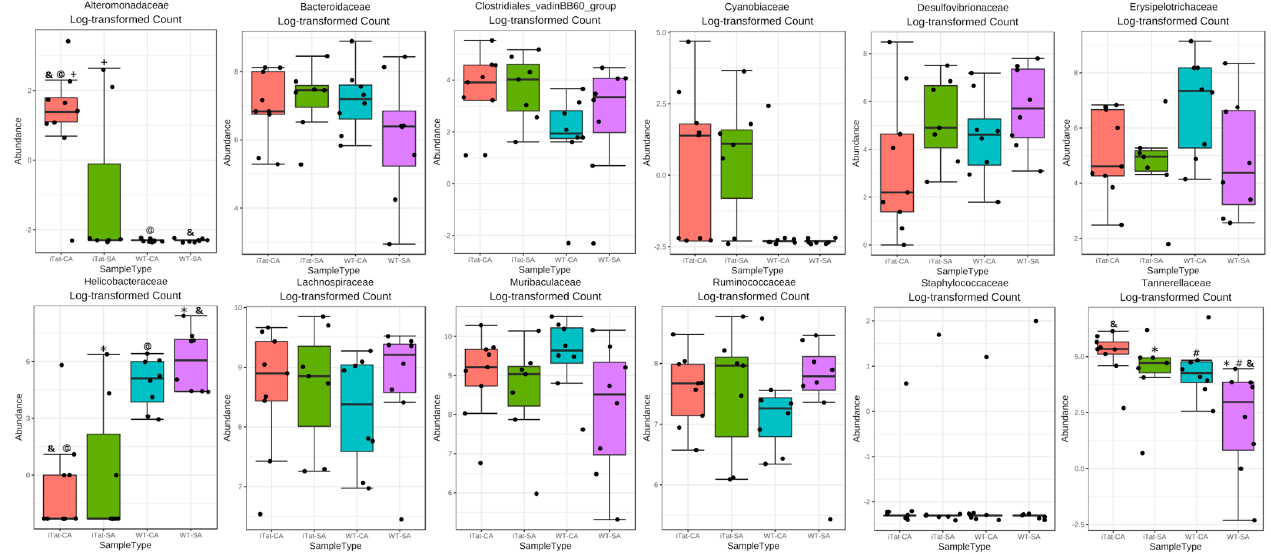
Figure 4. Effects of Tat expression and cocaine exposure on microbial abundance by family in the gut of 6-month male mice. Twelve families which were affected in either group were presented. The data were analyzed using Kruskal–Wallis test, followed by post hoc Games–Howell’s test. The families which were affected by Tat expression and/or cocaine exposure were marked in red. The error bars were SD, and “*”, “#”, “&”, “@” or “+” denoted p < 0.05. We next determined the e ff ects of Tat and cocaine on the gut microbiota of 12-month- old female mice. The most abundant 22 families identi fi ed in the gut microbiota of 12-